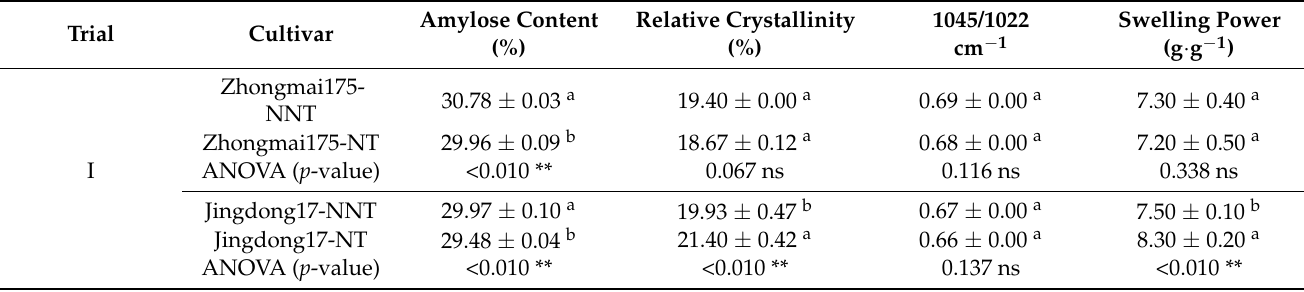
Table 1. Amylose content, relative crystallinity, short-range ordered degree (1045/1022) and swelling power of starch from Zhongmai 175 and Jingdong 17 at non-nitrogen (NNT), reduced nitrogen (NT), non-water (NWT), and reduced water (WT) treatments a,b